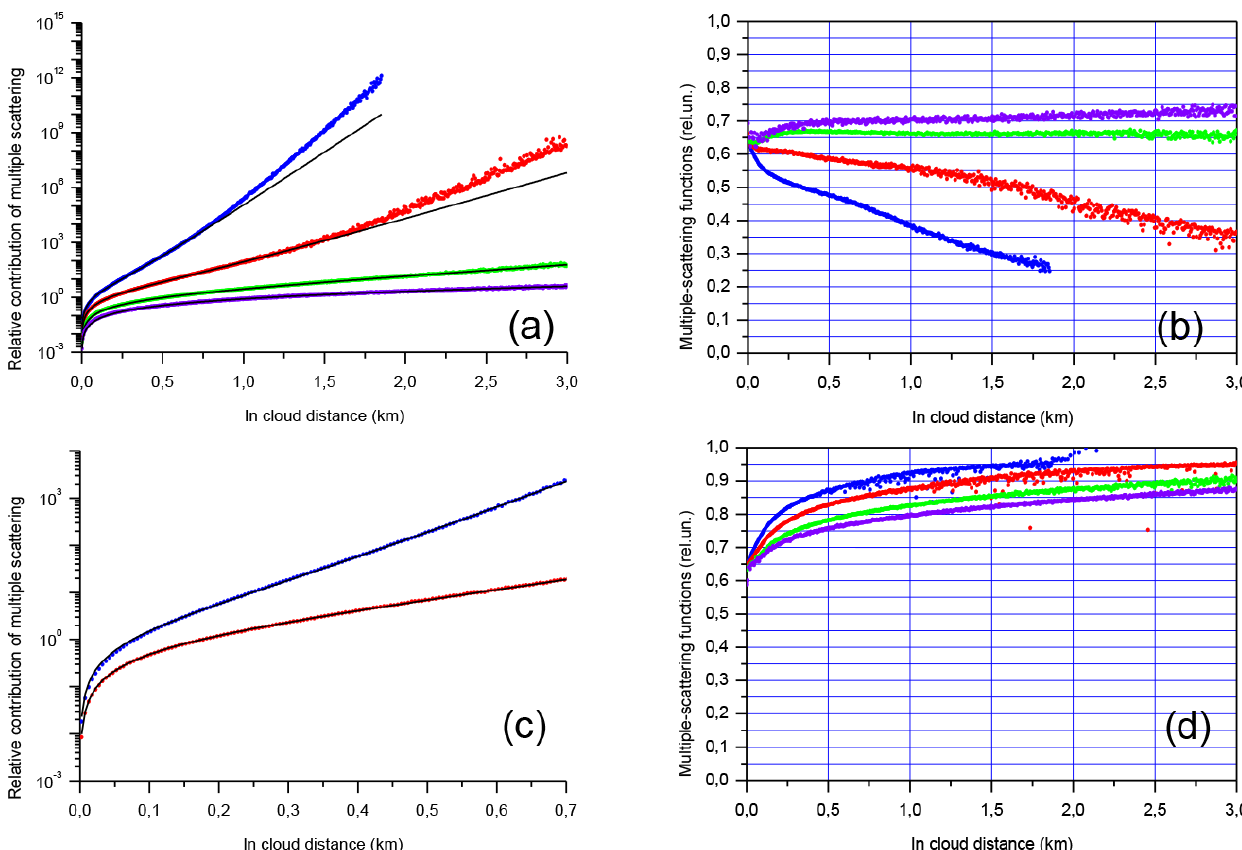
Figure 9. Multiple-scattering contributions R MSto1 to lidar signals (a) . Points – MC simulations, black lines – fitting with the empirical model. Panel (c) is the same as panel (a) but for the shorter in-cloud range, and only two values of the extinction coefficient are shown. Multiple-scattering functions η MS (d) for multiple scattering (b) and double scattering (d) . The extinction coefficient is 10.0km − 1 (blue